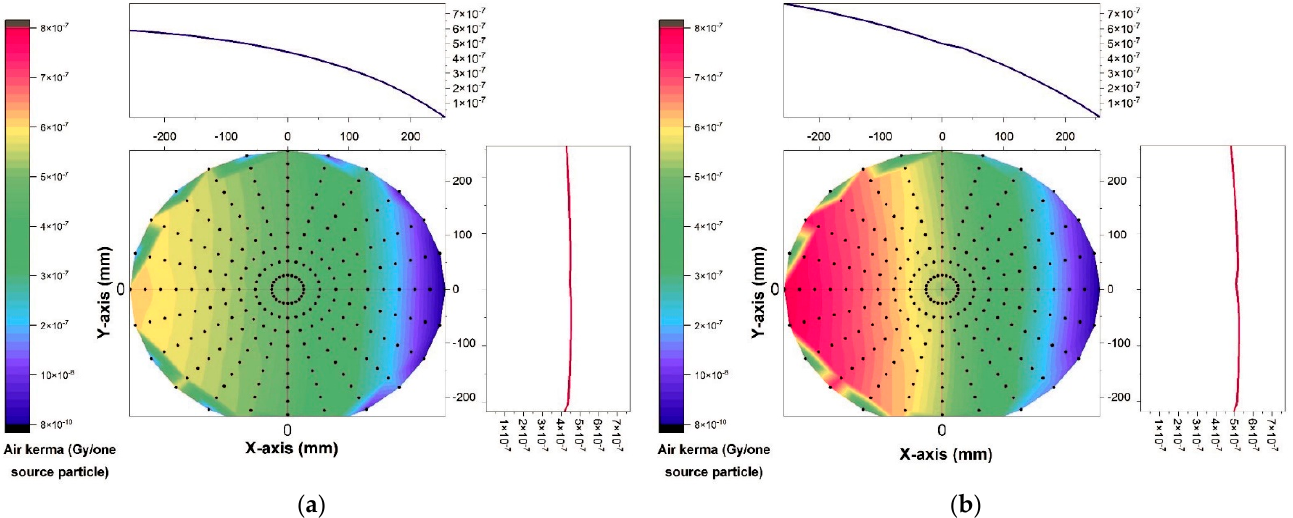
Figure 4. The air kerma determined with the help of the Monte Carlo method at ( a ) 60 kV and ( b ) 120 kV.